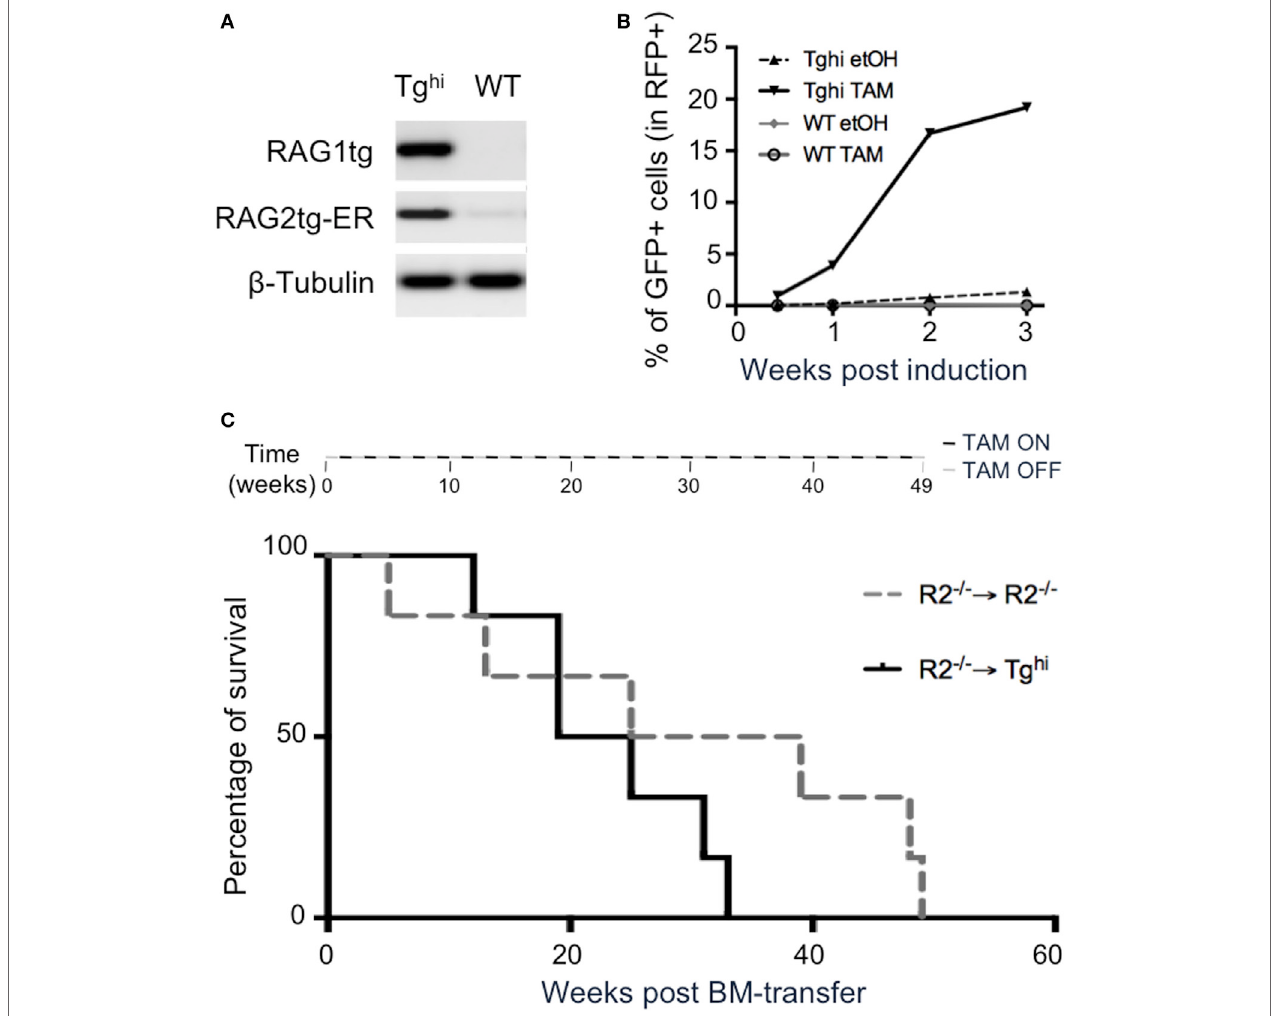
FigUre 8 | 4-Hydroxytamoxifen (TAM)-induction of recombination activating gene (RAG) activity in non-lymphoid organs. (a,B) Mouse embryonic fibroblasts (MEF) cultures were established from Tg hi and wild-type (WT) fetuses. (a) RT-PCR analysis revealed readily detectable Tg rag 1and Tg rag 2-ER transcripts in Tg hi MEF. (B) RAG activity was assessed using the GFPi recombination assay. Upon infection with viral GFPi-mRFP particles, transgenic MEF were treated with either 2% ethanol (etOH) or 2% ethanol containing 200 nM of 4-hydroxy-tamoxifen (TAM) during 3 weeks. GFP expression revealed by FACS analysis accounts for induced RAG activity. Results are representative of two independent experiments. (c) The upper scheme represents alternated on and off TAM administration during the 49 weeks duration of the experiment. The graph shows survival of R2 − / − (gray dotted line) and Tg hi (black line) mice reconstituted with R2 − / − bone marrow. Life span was not significantly different between the groups. N = 6 for each